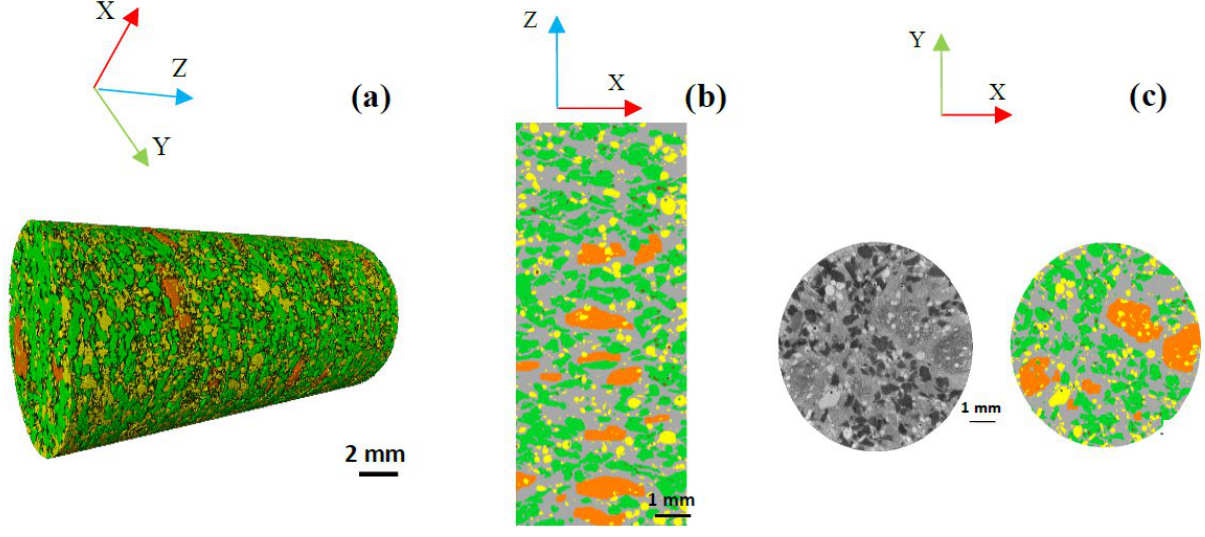
Figure 5. Spatial constituent distribution in M1; ( a ) 3D visualization, ( b ) 2D longitudinal visualization in XZ plane, ( c ) 2D orthogonal visualization in XY plane. Fiber bundles (orange), carbonaceous particles (green), matrix (gray), shots (yellow), voids (red).